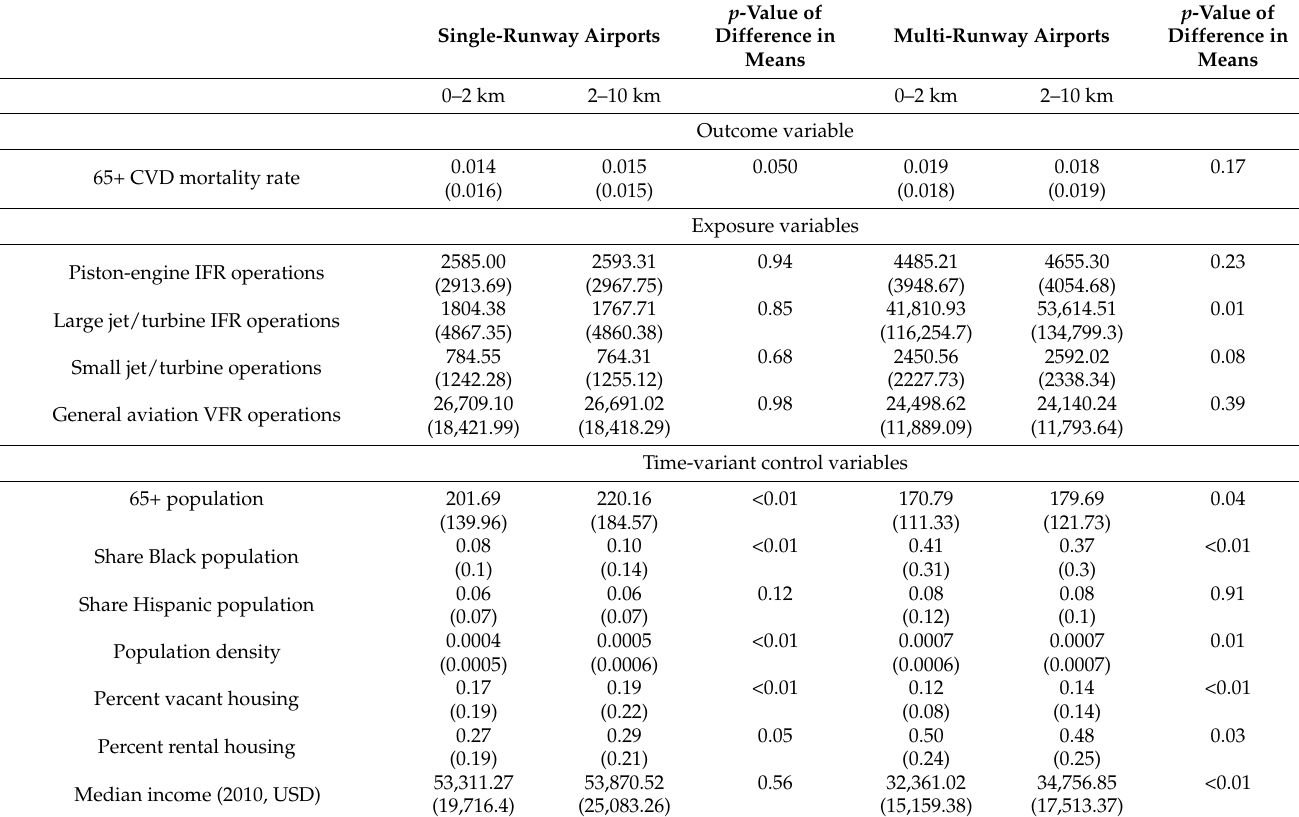
Table 2. Summary statistics by airport type and distance from airport: CEM sample.